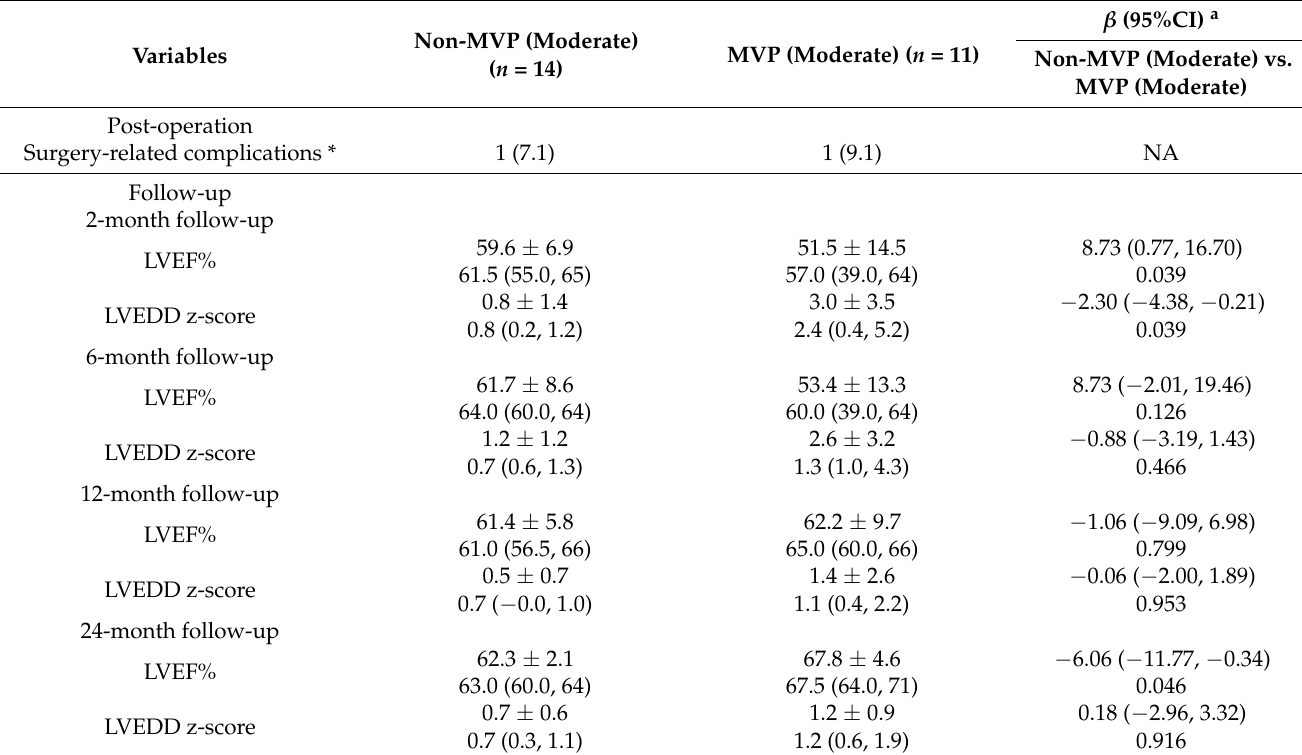
Table 4. Post-operative and follow-up information of ACAPA patients with moderate secondary